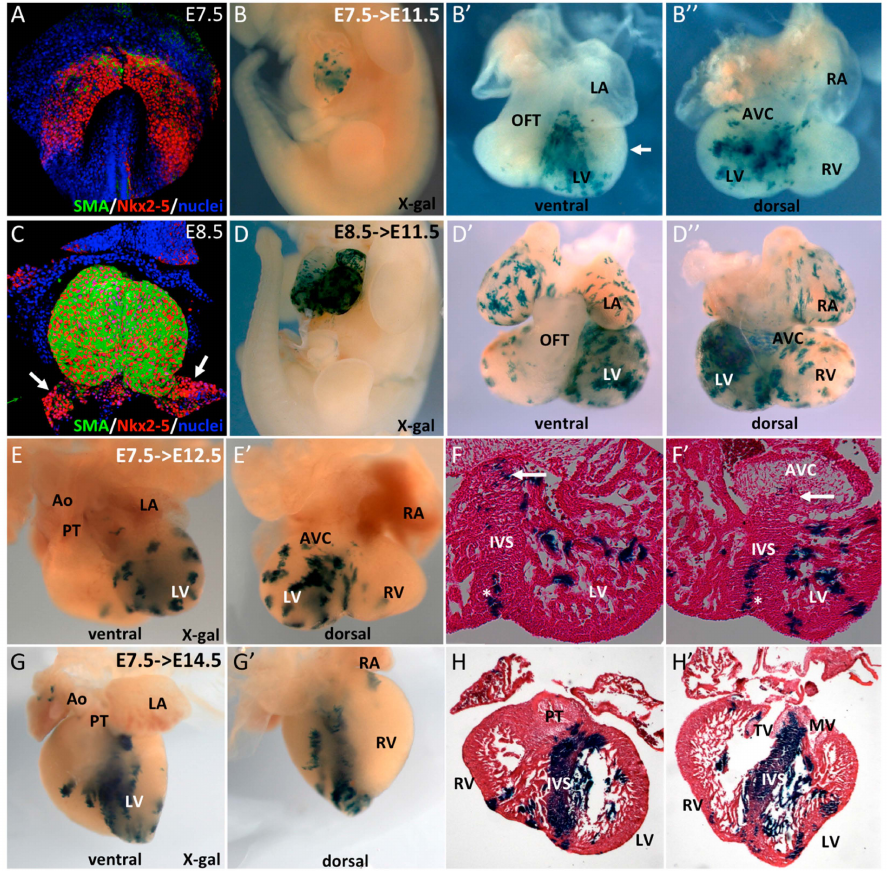
Figure 1. Early SMA+ cardiomyocytes contribute to the interventricular septum. ( A – C ) Whole-mount immunofluorescence reveals early expression of SMA in Nkx2-5+ cells. At E7.5, SMA is expressed in a subpopulation of cells in the cardiac crescent and, at E8.5, in the early heart tube with the exception of the venous pole (arrows). ( B – D ) Whole-mount X-gal staining of E11.5 Sma Cre {` ::R26R LacZ {` embryos after tamoxifen injection at E7.5 (B) or E8.5 ( D ). ( B’ , B” ) ventral and dorsal views of an E11.5 heart showing X-gal labeling in the left ventricle (LV) and interventricular septum (IVS). No labeling was observed in left ventricular free wall myocardium (arrow). ( D’ , D” ) ventral and dorsal view of E11.5 heart with X-gal labeling throughout the heart with the exception of the OFT. Ventral ( E , F ) and dorsal ( E’ , F’ ) whole-mount and serial sections of E12.5 Sma Cre {` ::R26R LacZ {` embryos after tamoxifen injection at E7.5. X-gal labeled cells are present in the LV and IVS with sparse positive cells at the upper part of the septum (arrows), in contrast to compact vertical clusters at the base of the IVS (stars). Ventral ( G , H ) and dorsal ( G’ , H’ ) whole-mount and serial sections of an E14.5 Sma Cre {` ::R26R LacZ {` embryo after tamoxifen injection at E7.5. X-gal labeling is intense in the IVS and few clusters are observed in the